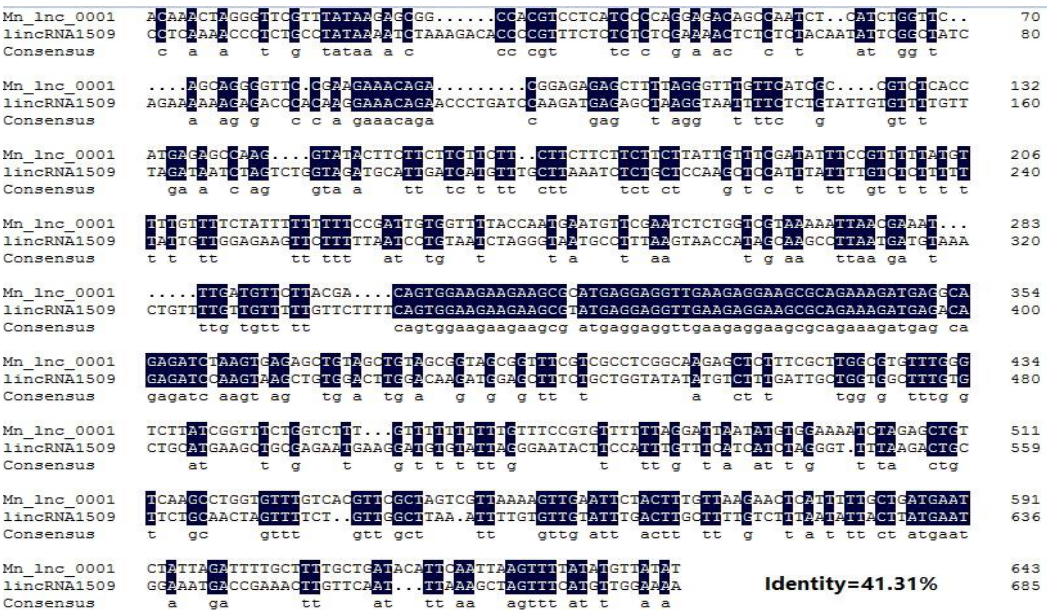
Figure 7. Alignment of the nucleotide sequences of Mn_lnc_0001 and lincRNA1509. Black and white backgrounds indicate conserved and non-conserved residues, respectively.